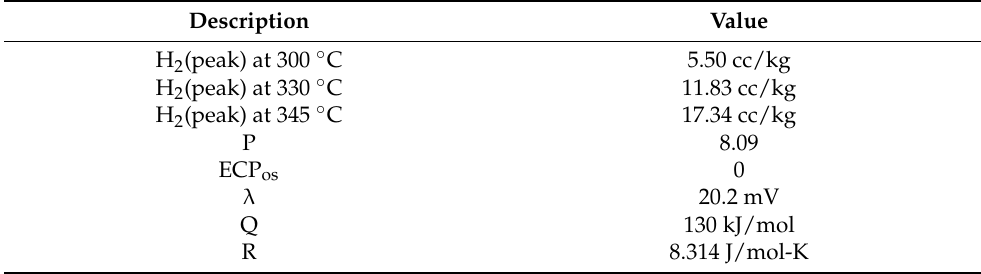
Table 6. Values of the parameters used to calculate the crack growth rate factor